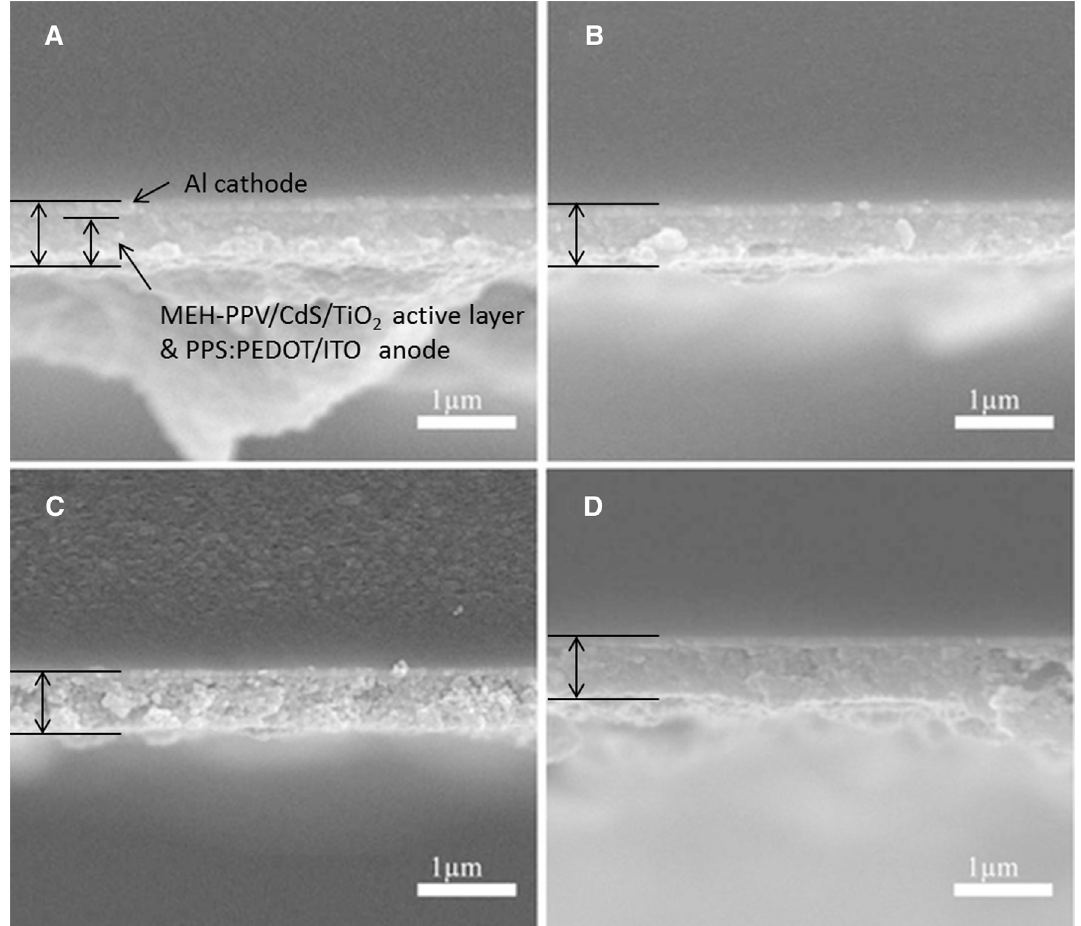
Figure 9 SEM pictures of BHJSC active layer blends: A1 (A), A2 (B), S1 (C), and S2 (D).